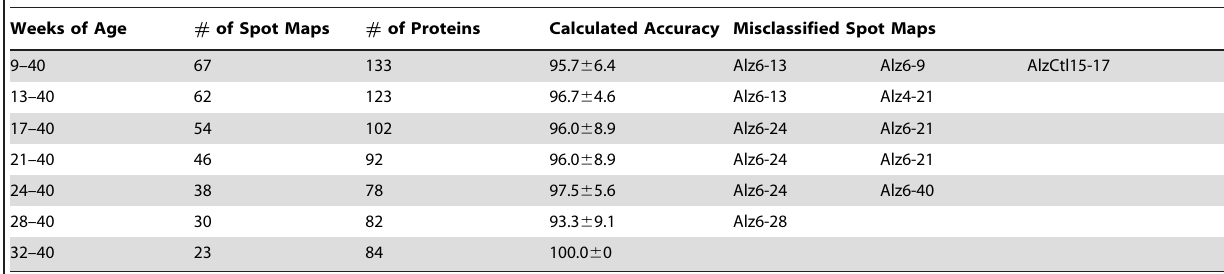
Table 1. Alzheimer’s Disease Model